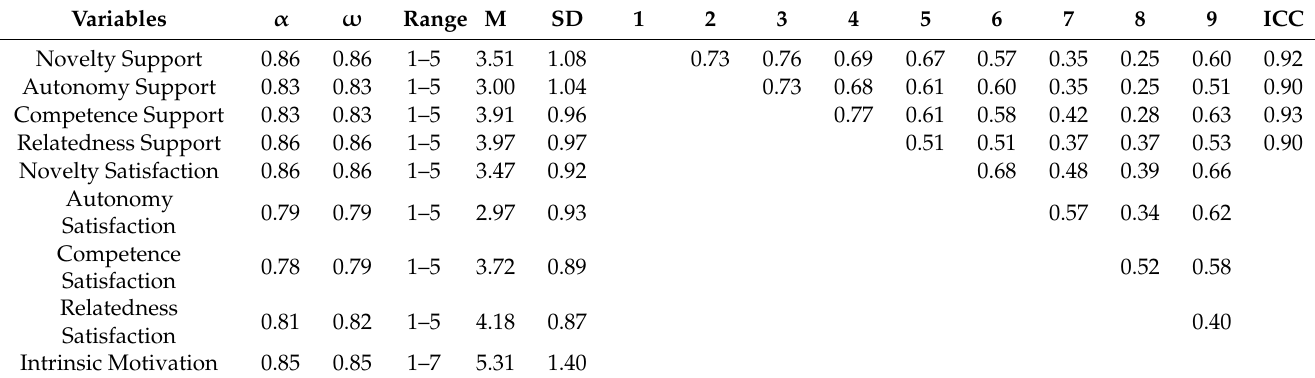
Table 4. Reliability, temporal stability, descriptive statistics, and correlations of study